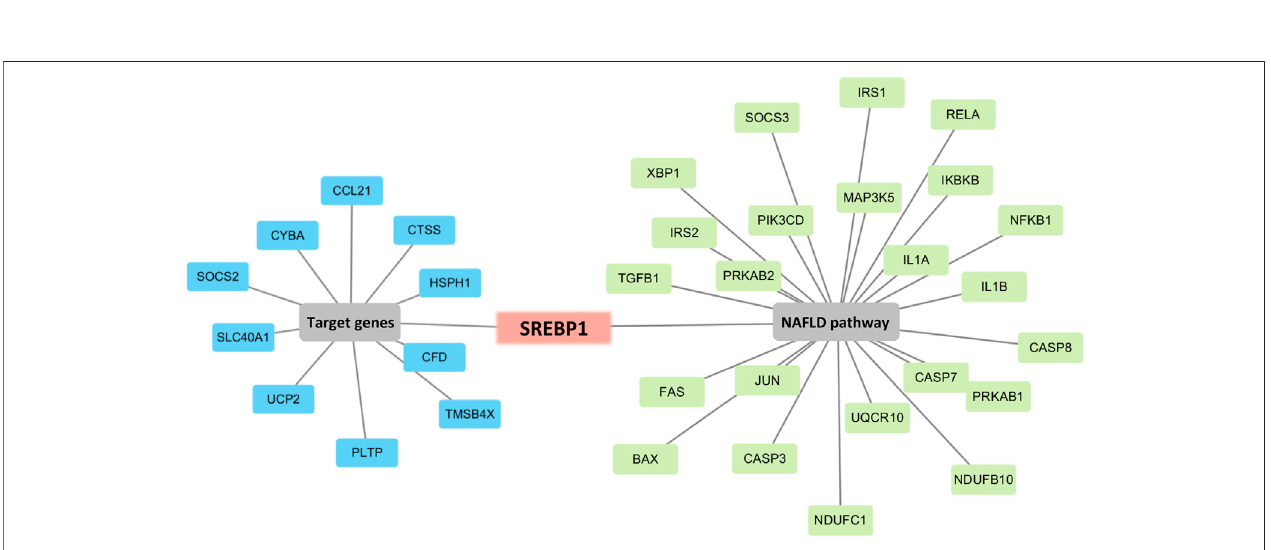
FIGURE 6 | Screening of the key regulated gene. Combining target genes with MAFLD pathway genes, only Srebp-1 was screened out. The blue box represents target genes, the green box represents genes participating in the MAFLD pathway, and the red box represents genes involved in both the target genes and the MAFLD pathway.